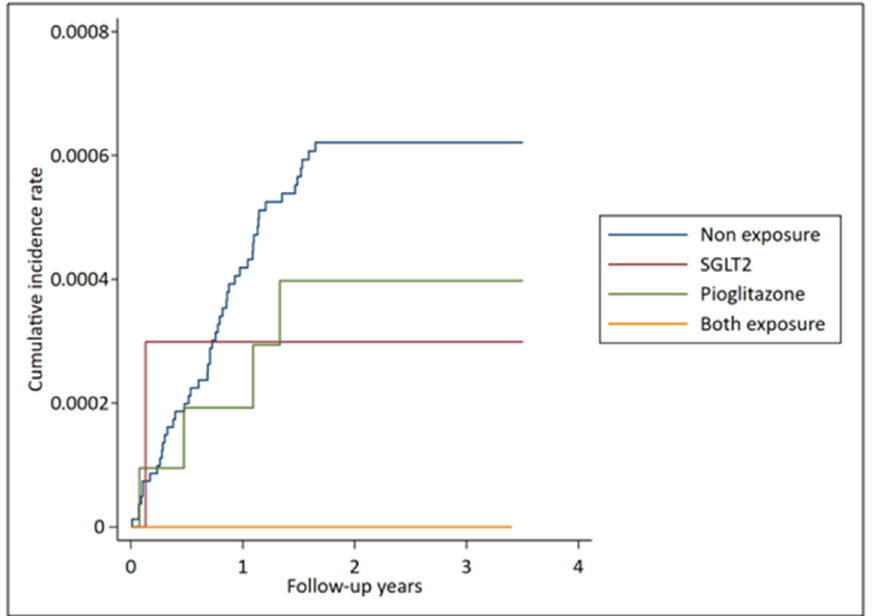
Figure 2. Cumulative incidence of newly diagnosed bladder cancer in each group. Table 3. Risks of bladder cancer and all-cause mortality according to exposure of study drugs.